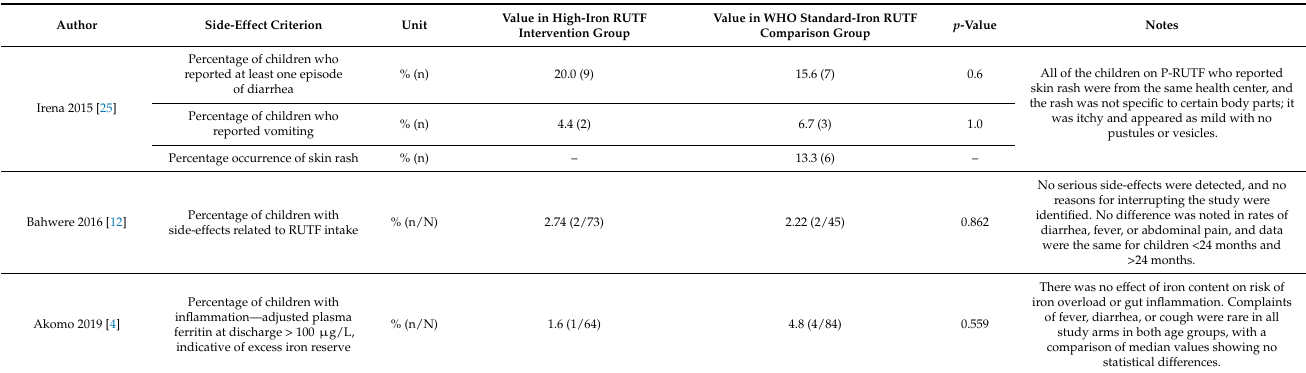
Table 5. Description of side-effect profiles in the included